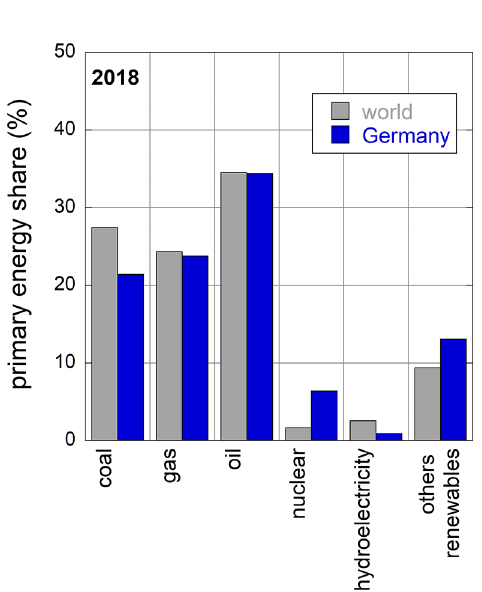
Fig. 3. – The primary energy use of the world and of Germany is split up into the various sources. The world data represent the average situation, the ones of Germany those of a historically technology oriented country. Data from “Our World in